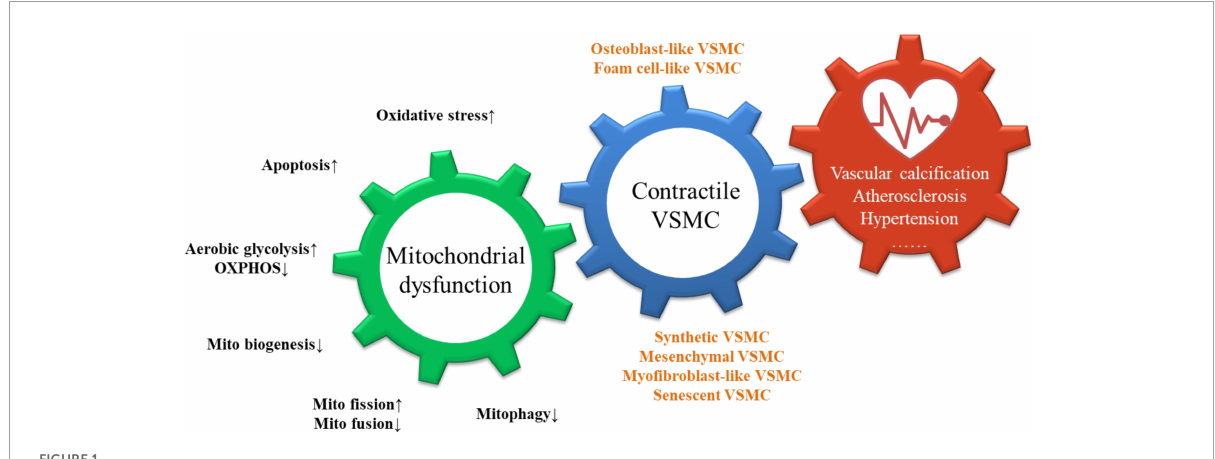
FIGURE1 Consequences of mitochondrial dysfunction in